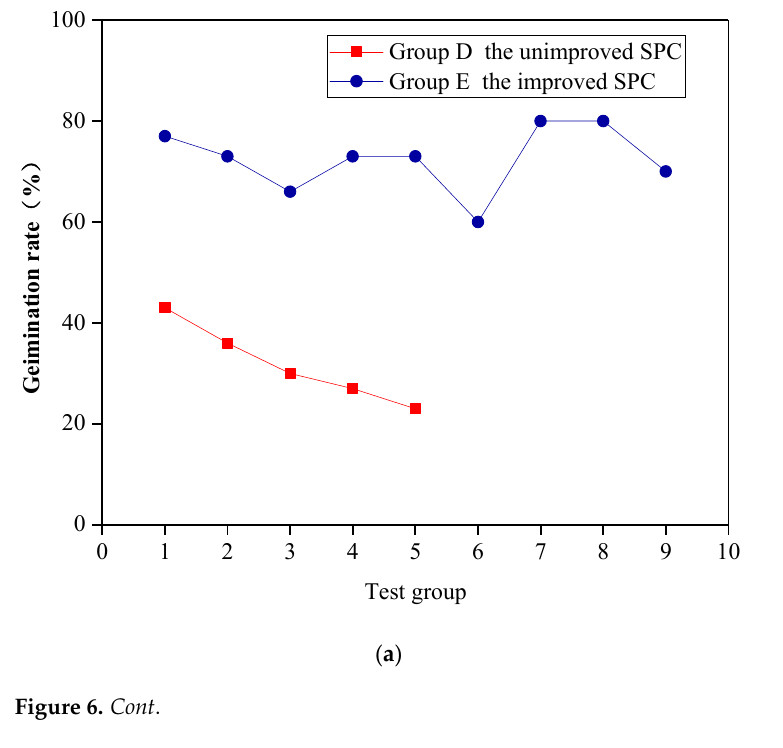
Figure 5. Result of plant growth test with improved SPC.